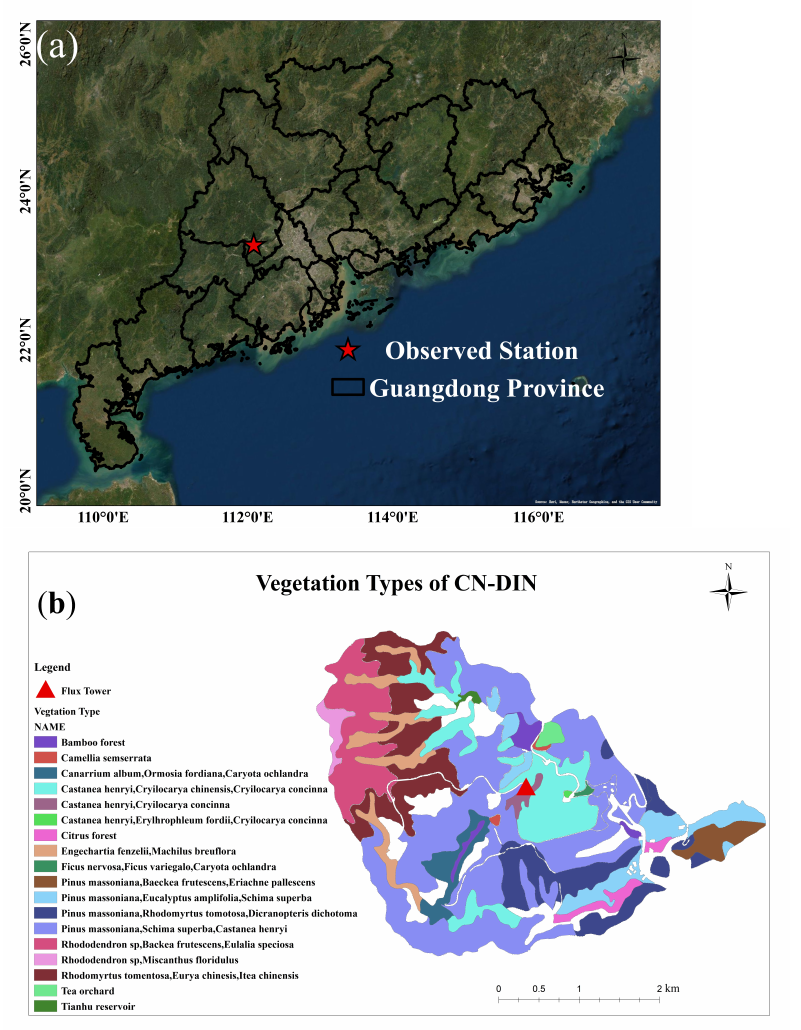
Figure 1. ( a ) Geographic location of the observed station. ( b ) Vegetation types at the